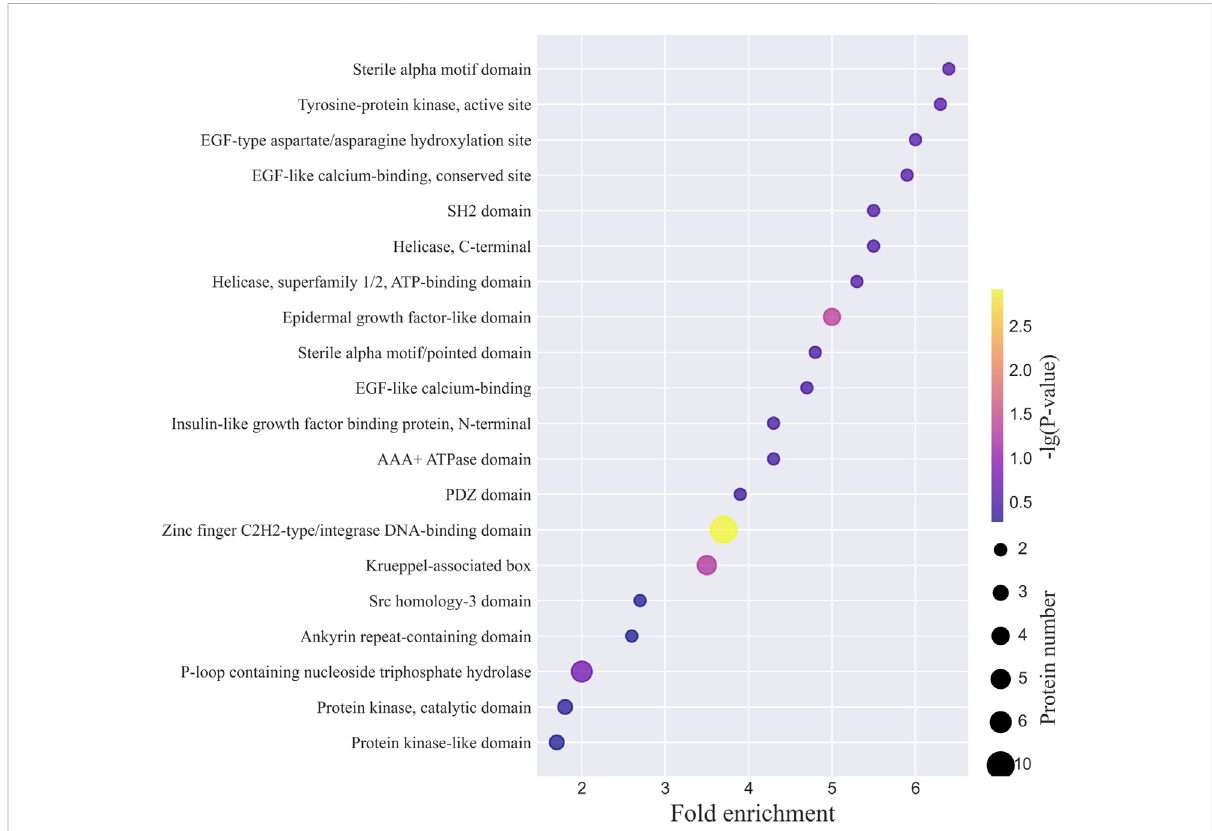
FIGURE 7 Top 20 INTERPRO domains of N-glycoproteins corresponding to intact N-glycopeptides with Neu5Gc identi fi ed from MCF-7 cancer